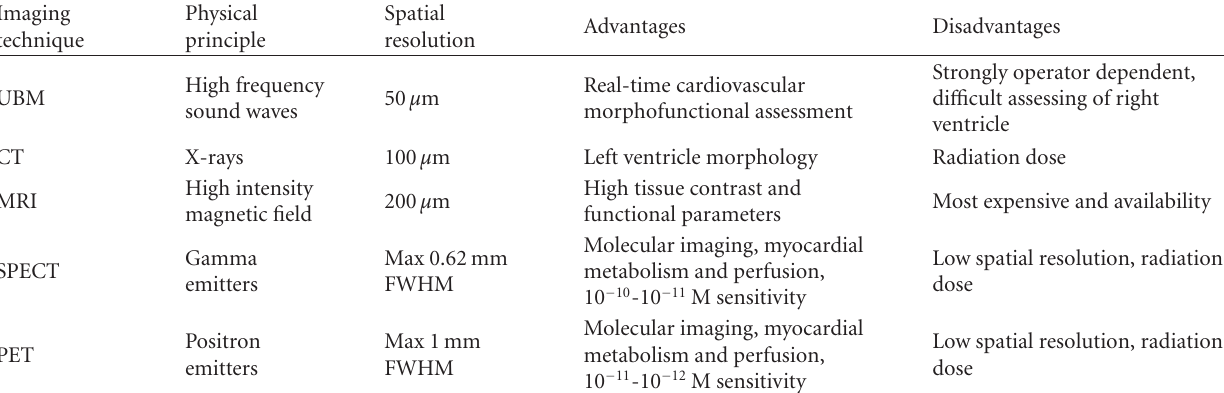
Table 1: Principal characteristics of small animal imaging techniques in cardiovascular research.